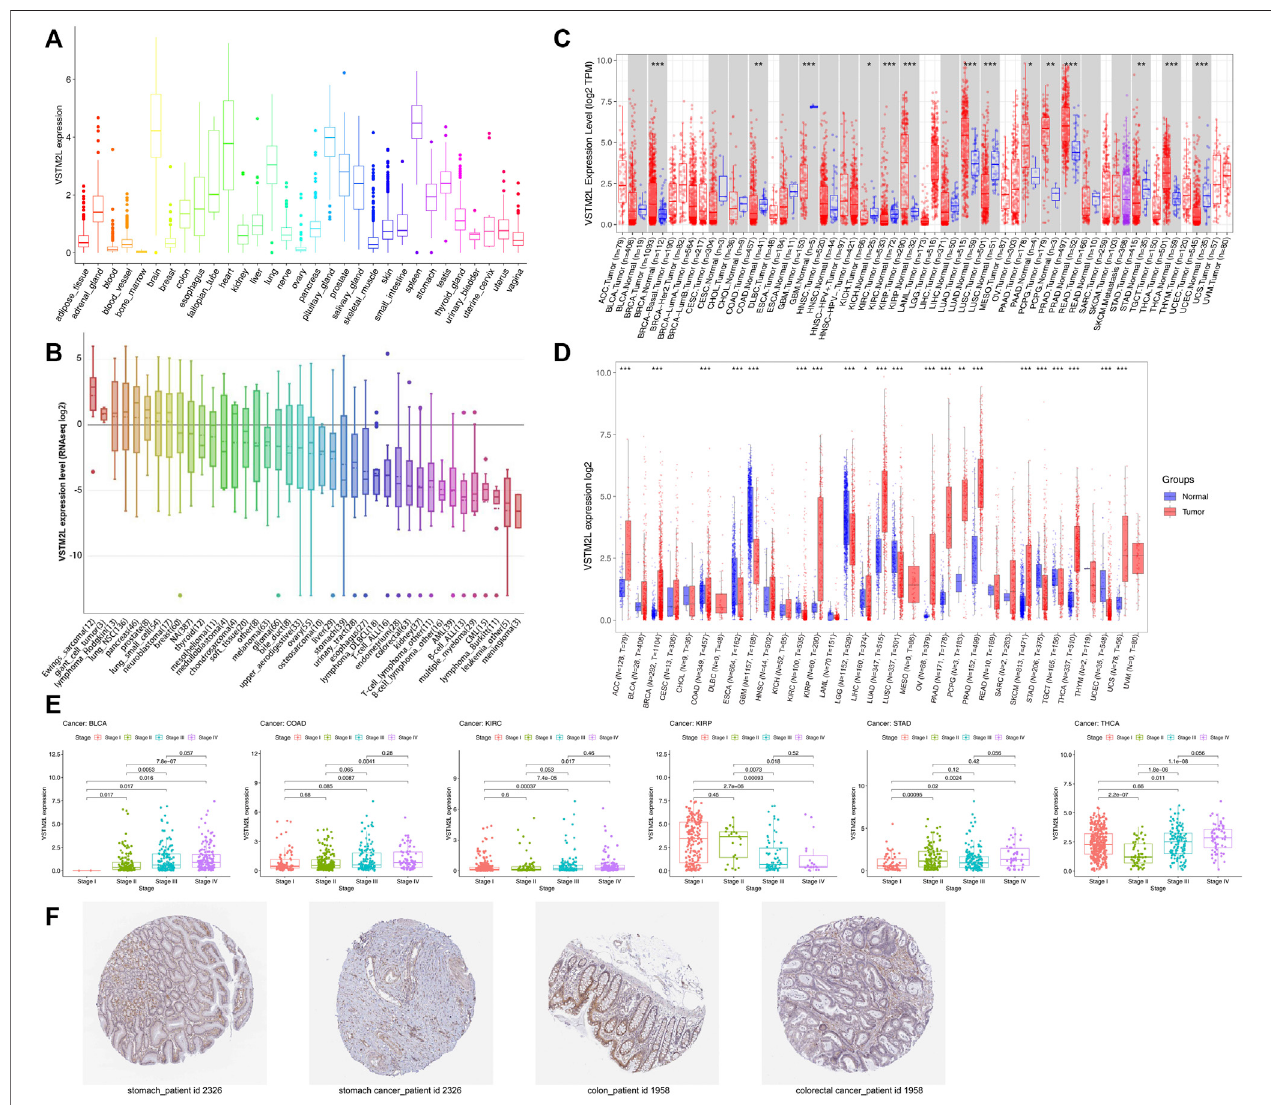
FIGURE1 | VSTM2L expression indifferentcancers. (A) RNA-seq data of VSTM2L expression level in human cancercell lines in the CCLE database. (B) VSTM2L expression data of 31 normal tissues from GTEx datasets. (C) Differential expression of VSTM2L in various cancer types based on TCGA data in TIMER. (D) VSTM2L expression level in 33 cancer types from combined GTE and TCGA data. (E) Relationship between VSTM2L expression level and clinical stage in BLCA, COAD, KIRC, KIRP, STAD, and THCA. (F) Immunohistochemical detection of VSTM2L protein expression in the tumor and corresponding normal tissue of a STAD patient (ID: 2,326) and COAD patient (ID: 1958) in the HPA database. * p < .05, ** p < .01, *** p <